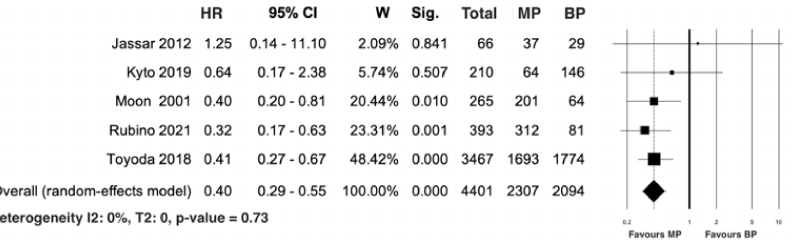
Figure 10. Forest plot for prosthesis reintervention. Abbreviations: HR, hazard ratio; CI, confidence interval; W, weight; MP, mechanical prosthesis; and BP, biological prosthesis.